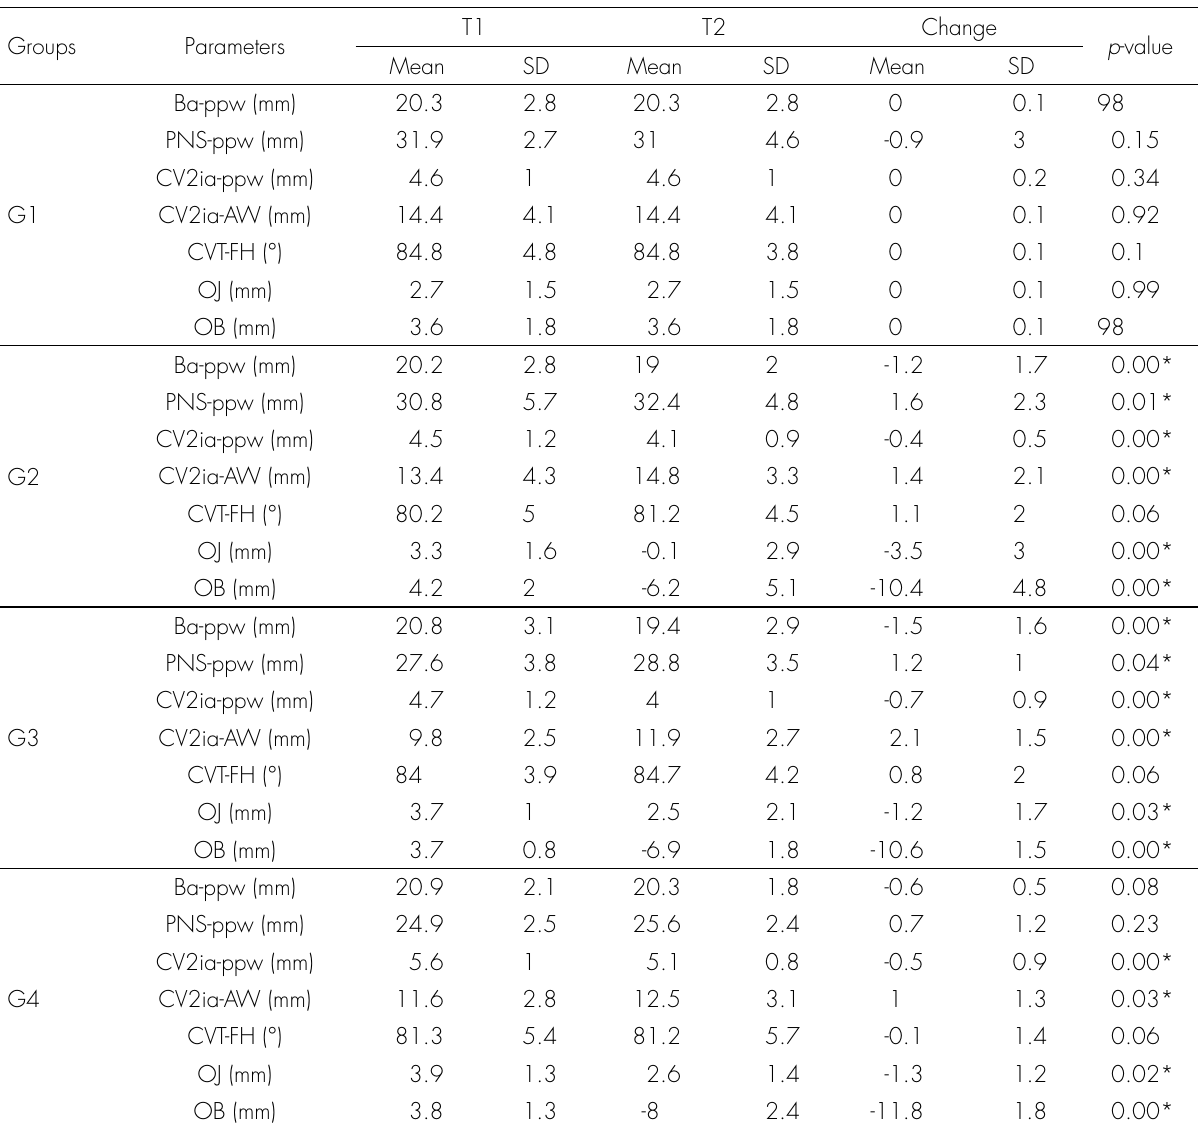
Table V. Comparison of craniofacial parameters between T1 and